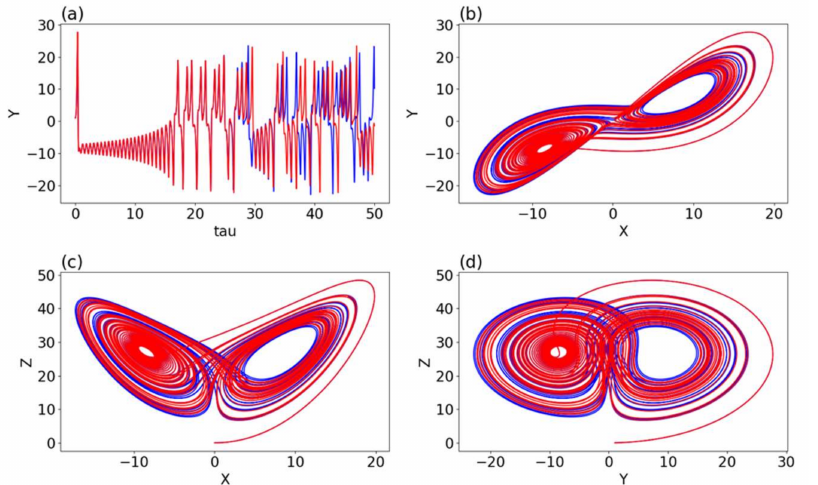
Figure 1. The sensitive dependence on initial conditions ( a ) and diverged trajectories ( b – d ) using the Lorenz 1963 model with r = 28 and σ = 10. Each panel displays solutions from the control (in blue) and parallel (in red) runs, respectively. The control run has an initial condition of (X, Y, Z) = (0, 1, 0), and the parallel run additionally includes a small perturbation (1 × 10 − 10 ) in the initial value of Y. Chaotic solutions in the X-Y-Z phase space within the Lorenz model can be found in Figure 2 of